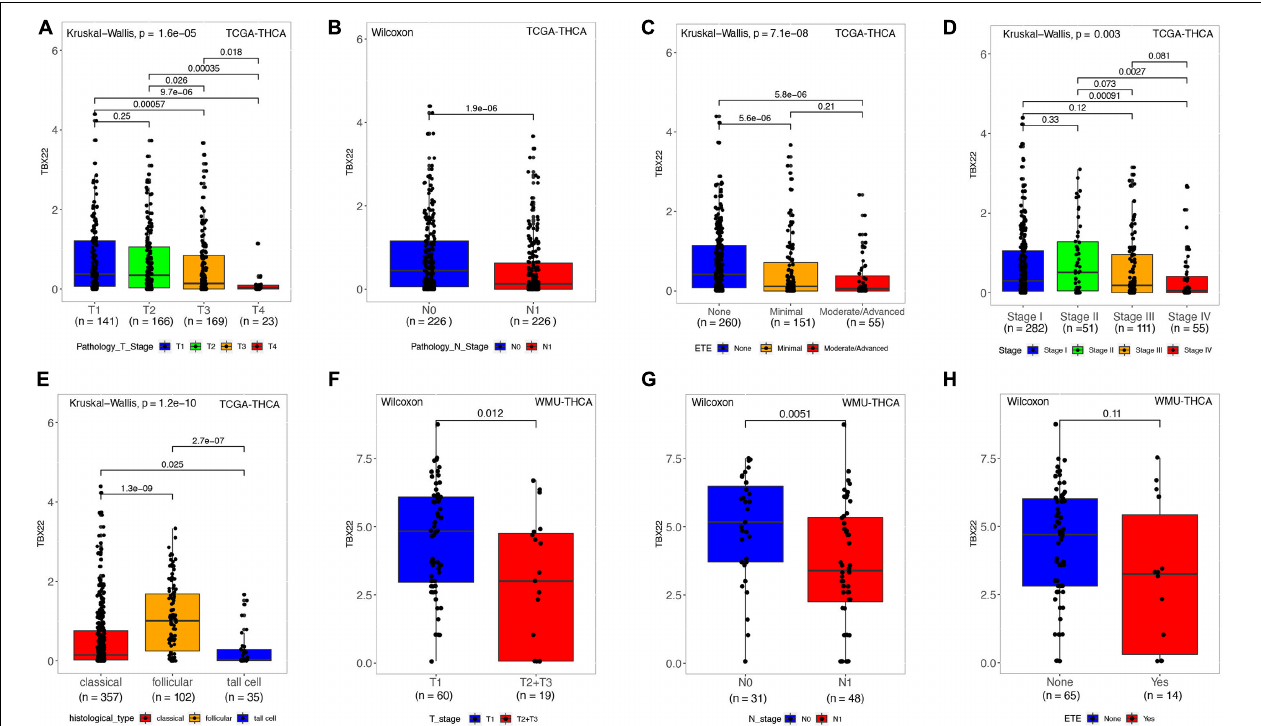
FIGURE 2 | TBX22 expression and correlation with clinicopathological characteristics in PTC patients. (A–E) In the TCGA-THCA dataset, TBX22 expression in the different status of tumor size, lymph node metastasis, extrathyroidal extension, disease stages, and histological types. (F–H) In the local cohort, TBX22 expression in the different status of tumor size, lymph node metastasis, and extrathyroidal extension. (A,C–E) Kruskal–Wallis test; (B,F–H) Wilcoxon rank-sum